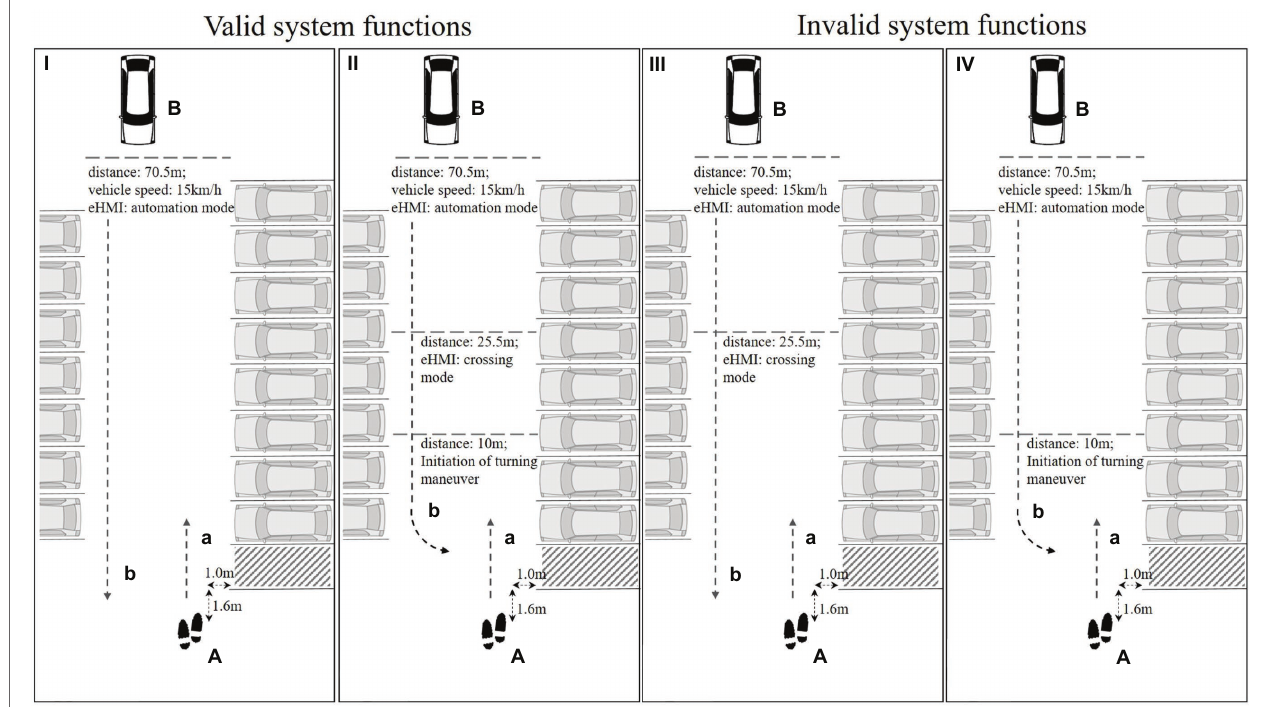
FIGURE 1 | Schematic overview of the investigated scenario in the parking lot (top view). (A) The footprints represent the pedestrians’ perspective (i.e., the camera’s position), (a) displays the participants’ instructed trajectory for crossing the empty parking space (i.e., dashed area). (B) The vehicle indicates the approaching interaction vehicle including an augmented light-based eHMI in the windscreen, (b) displays the respective trajectory of the interaction vehicle that was recorded in the videos. The displayed distances of the interaction vehicle to video start, the transition of eHMI signals (when crossing mode was presented), and the initiation of the turning maneuver are displayed with respect to the camera’s position (i.e., the pedestrians’ perspective). (I and II) Valid system functions; (III and IV) invalid system functions.